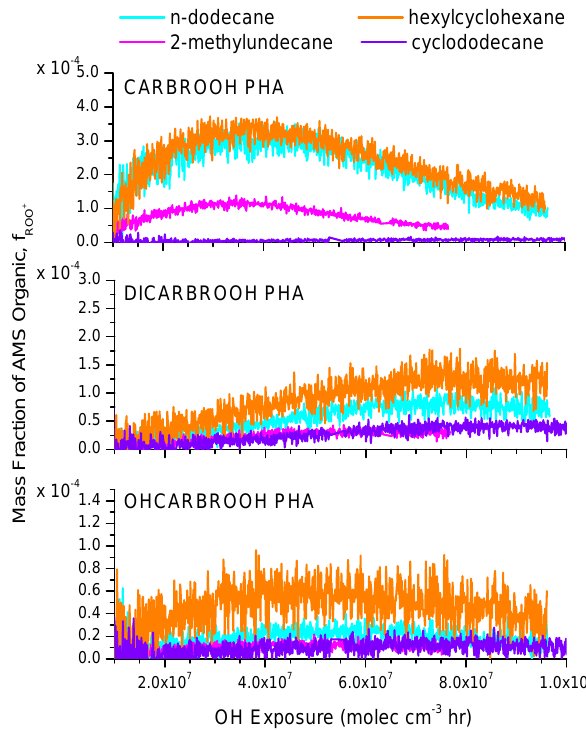
Fig. 9. Fraction of organic attributed to the corresponding ROO + PHA tracer ion for (top) carbonyl hyderoperoxide PHA (CAR- BROOH PHA), (middle) dicarbonyl hydroperoxide (DICAR- BROOH), and (bottom) hydroxycarbonyl hydroperoxide (OHCAR-